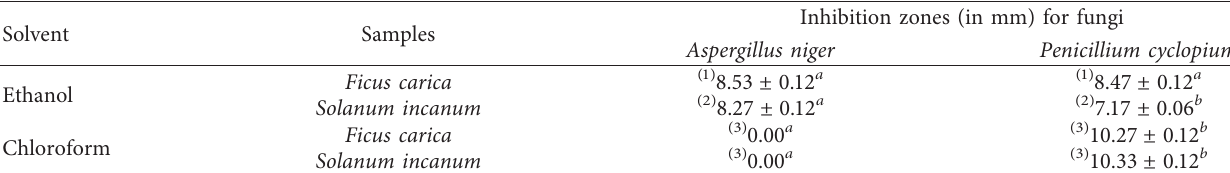
Table 7: Inhibition zones, including well diameter, of samples against fungal growth.